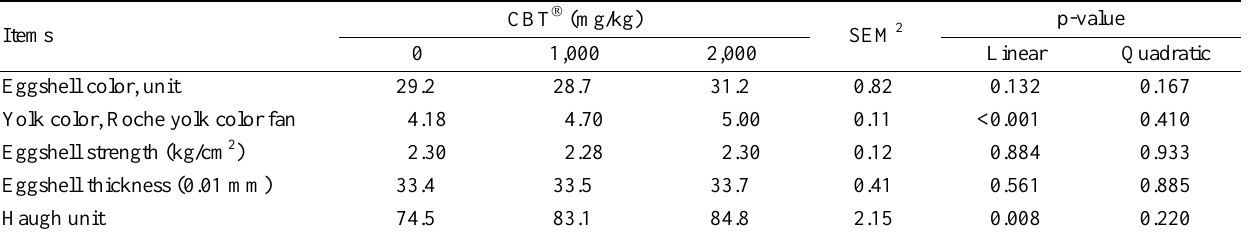
Table 3. Effects of dietary CBT  supplementation on egg quality in laying hens 1